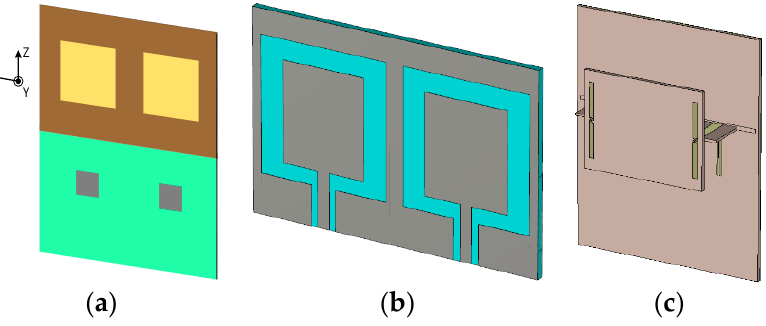
Figure 5. Three types of two-element antenna arrays used for performance comparison. ( a ) A high linear–polarization patch array; ( b ) a high-isolation monopole array; and ( c ) a high linear–polarization dipole array.